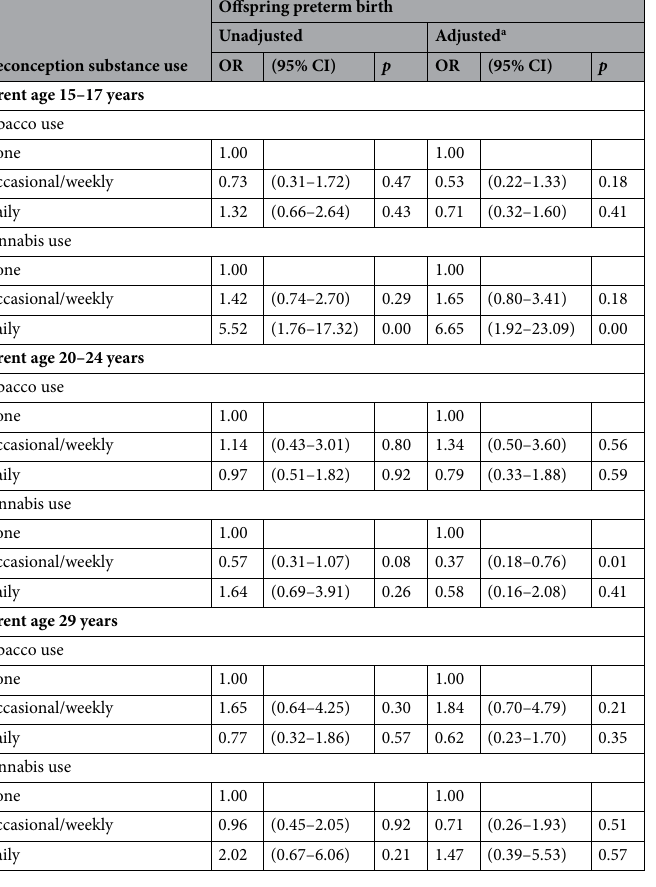
Table 2. Logistic regression analysis of relationship between tobacco/cannabis use frequency at age 15–17, 20–24 and 29, and preterm birth in 1030 children born to 665 parents (OR = odds ratio, CI = confidence interval). a All adjusted models adjusted for baseline/adolescent covariates: parent sex, offspring sex, family SES, grandparent education level, grandparent smoking status, adolescent mental health, and concurrent use of cannabis for models where tobacco is the exposure and vice versa. Adjusted models at age 20–24 years also include adjustment for frequency of use of the substance at age 15–17 years. Adjusted models at age 29 years models also include adjustment for frequency of use of the substance at age 15–17 and age 20–24